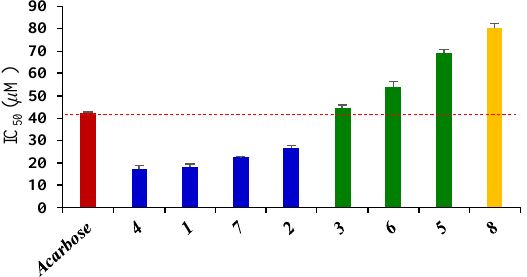
Figure 4. Half-maximal inhibitory concentrations (IC 50 ) of the screened individual. α -glucosidase inhibitor of compounds 1 – 8 from Cirsium setosum.